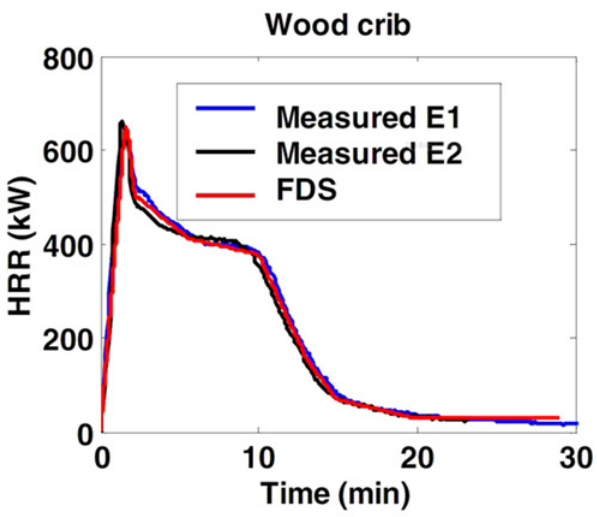
Fig 6. Heat release rate (HRR) curve of the wood model [31]. (Rinne et al., 2007).